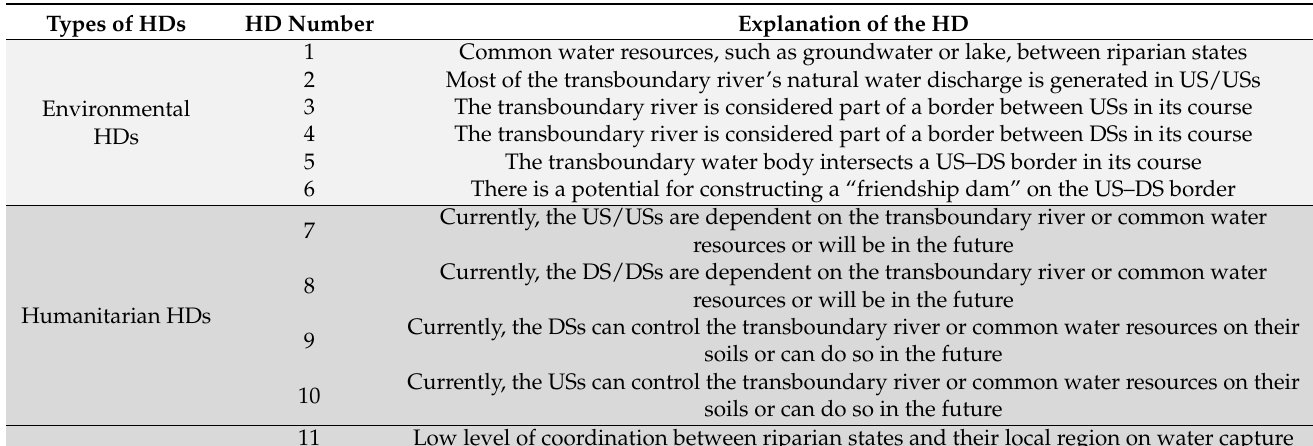
Table 1. Human–environmental factors specific to each HSA.